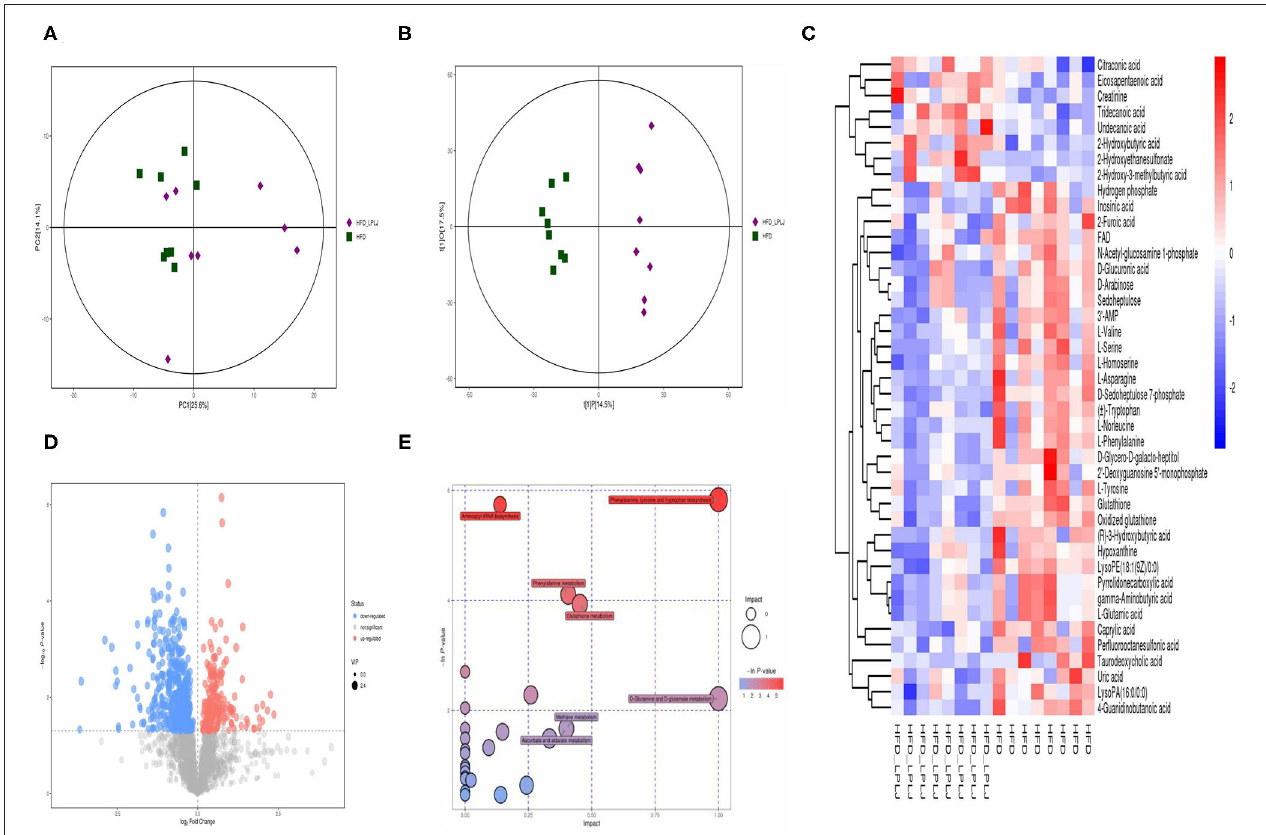
FIGURE 7 | Liver metabolomic profiling by UPLC-QTOF/MS in negative model (ESI-) ( n = 8 for each group). (A) PCA score plot for the HFD and LPLJ groups; (B) OPLS-DA score plot for the HFD and LPLJ groups; (C) Heatmap of relative abundance of significantly different metabolites (VIP > 1.0, and p < 0.05) between the HFD and LPLJ groups; (D) Permutation test from PLS-DA models, (E) The metabolic pathway impact prediction between the HFD and LPLJ groups in liver based on KEGG online database. The -ln(p) values from the pathway enrichment analysis are indicated on the horizontal axis, and the impact values are indicated on the vertical